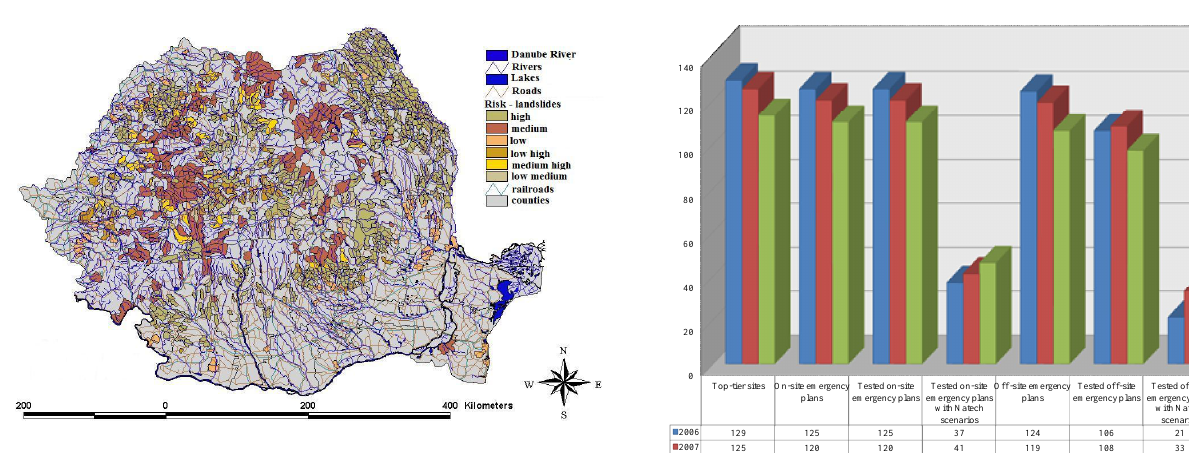
Fig. 6. Landslide risk map of Romania (Law no. 575/2010). Figure 6. Landslide risk map of Romania (Law no 575/2010) 3